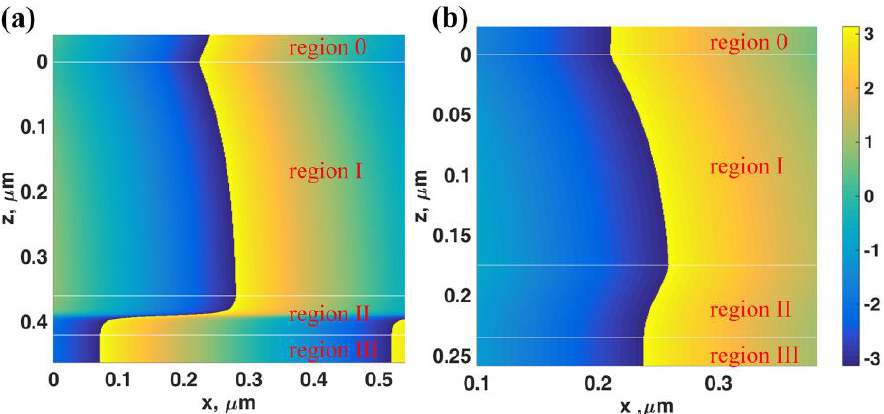
Figure 4. Phase profiles of E x in rad for ( a ) LRSPP mode labelled ‘A’ in Figure 3b: n 0 sinθ 0 = 1.4156, n 1 = 1.34 with d 1 = 360 nm, n 2 = 0.18344 + 3.4332 i with d 2 = 60 nm and n 3 = 1.34 and ( b ) SRSPP mode labelled ‘B’ in Figure 3b: n 0 sinθ 0 = 1.513, n 1 = 1.34 with d 1 = 175 nm, n 2 = 0.18344 + 3.4332 i with d 2 = 60 nm and n 3 = 1.34.